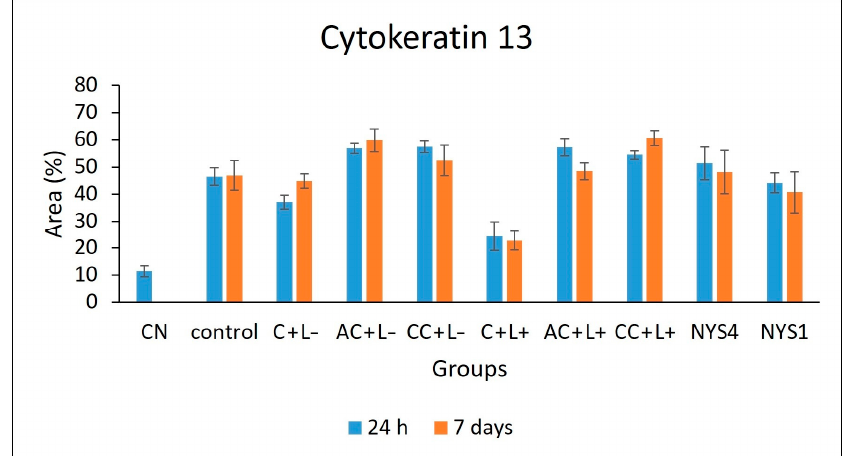
Figure 7. Mean values of CK13 immunolabelling area measured by ImageJ software ( n = 2). NC group: healthy and untreated animals; control group: infected animals that did not receive any treatment (C − L − ); C + L+, AC + L+, and CC + L+ groups: animals treated with aPDT mediated by free CUR, anionic and cationic CUR-NP, respectively, and blue LED light; C + L − , AC + L − , and CC + L − groups: evaluation of each PS alone (free CUR, and anionic and cationic CUR-NP, respectively); NYS1 and NYS4 groups: animals treated with Nystatin 100,000 IU once (under anesthesia) and four times daily, respectively. Error bars: standard deviation.